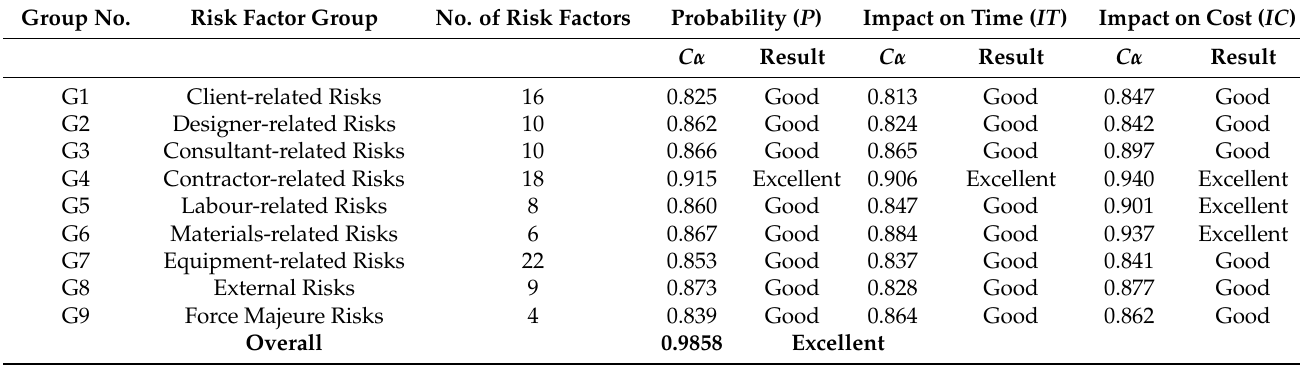
Table 5. Reliability analysis (Cronbach’s alpha) for the risk factors.